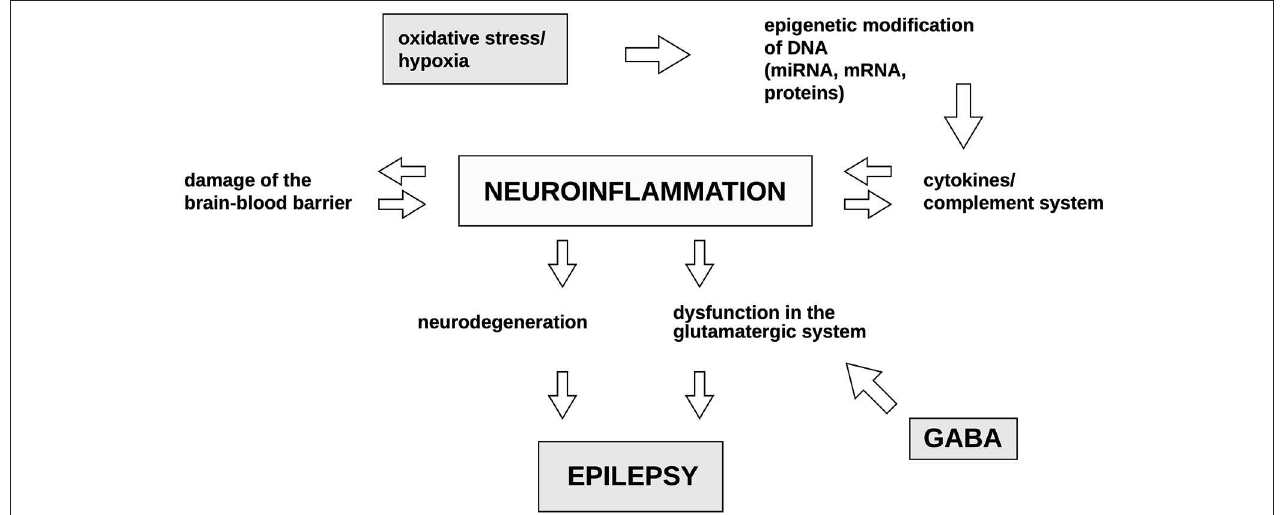
FIGURE 2 | Potential mechanisms occurring during epileptogenesis and their correlations with one another. Both oxidative stress and hypoxia have been previously reported to induce epigenetic modifications of DNA. This may result in the activation of cytokines and the complement system. Consequently, the resulting neuroinflammatory processes may in turn induce the production of cytokines and the elements of the complement system in a feedback loop. Neuroinflammation is the primary factor which leads to BBB destruction, neurodegeneration and the dysfunction in the glutamatergic system resulting in the dysregulation of GABA synthesis. Culmination of the above-mentioned mechanisms result in epilepsy. GABA, gamma-Aminobutyric acid. Illustration by Paulina